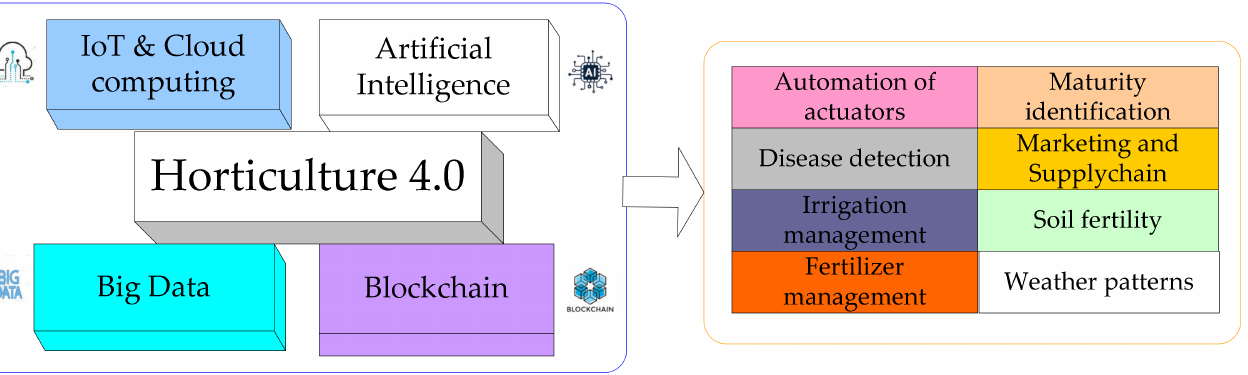
Figure 1. Horticulture